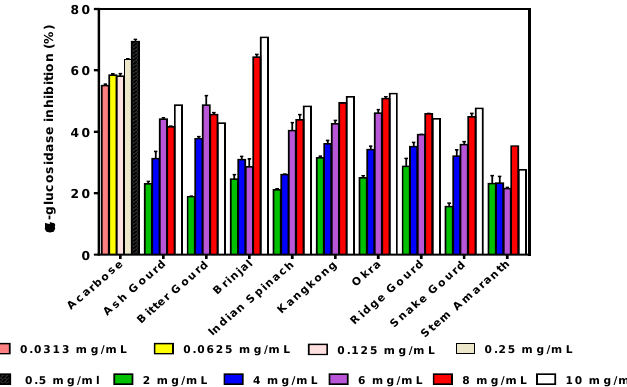
Figure 2. Inhibition of α-glucosidase activity at different concentrations of acarbose and aqueous polyphenolic extracts of vegetables. Bars are means ( n = 3) ± standard deviation.